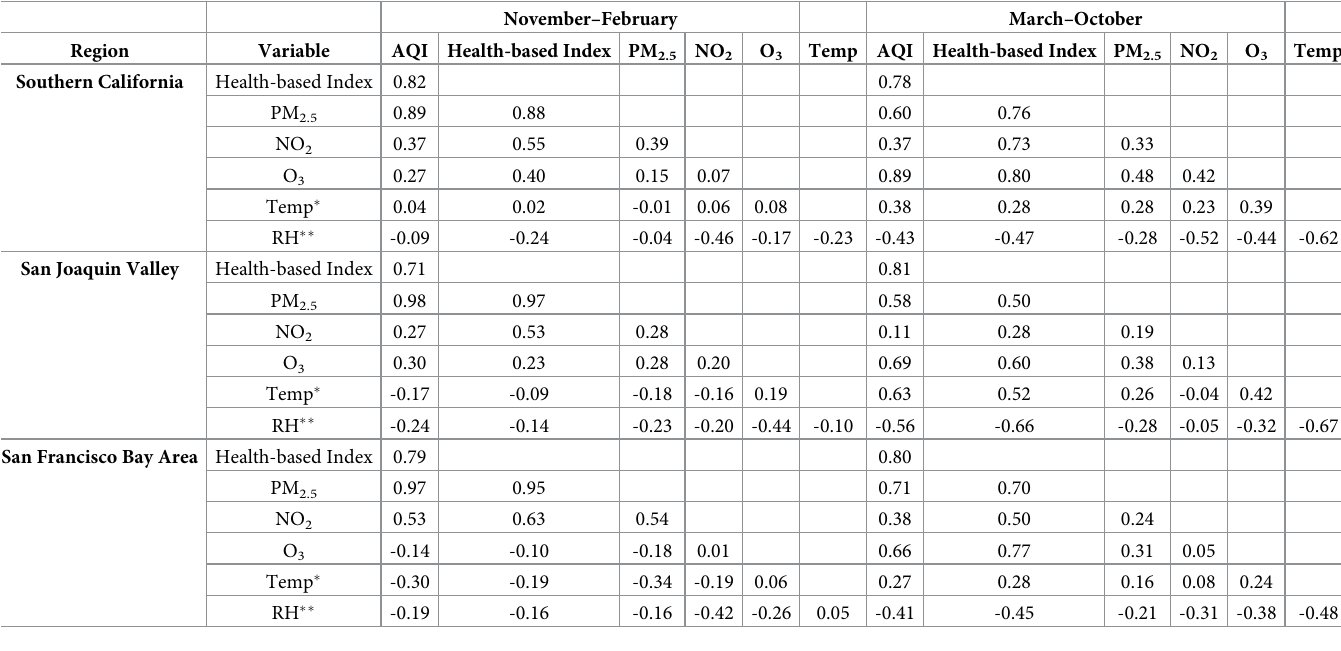
Table 3. Spearman correlations by season and region for air pollutants and meteorological variables, from 2012–2014. Region Southern